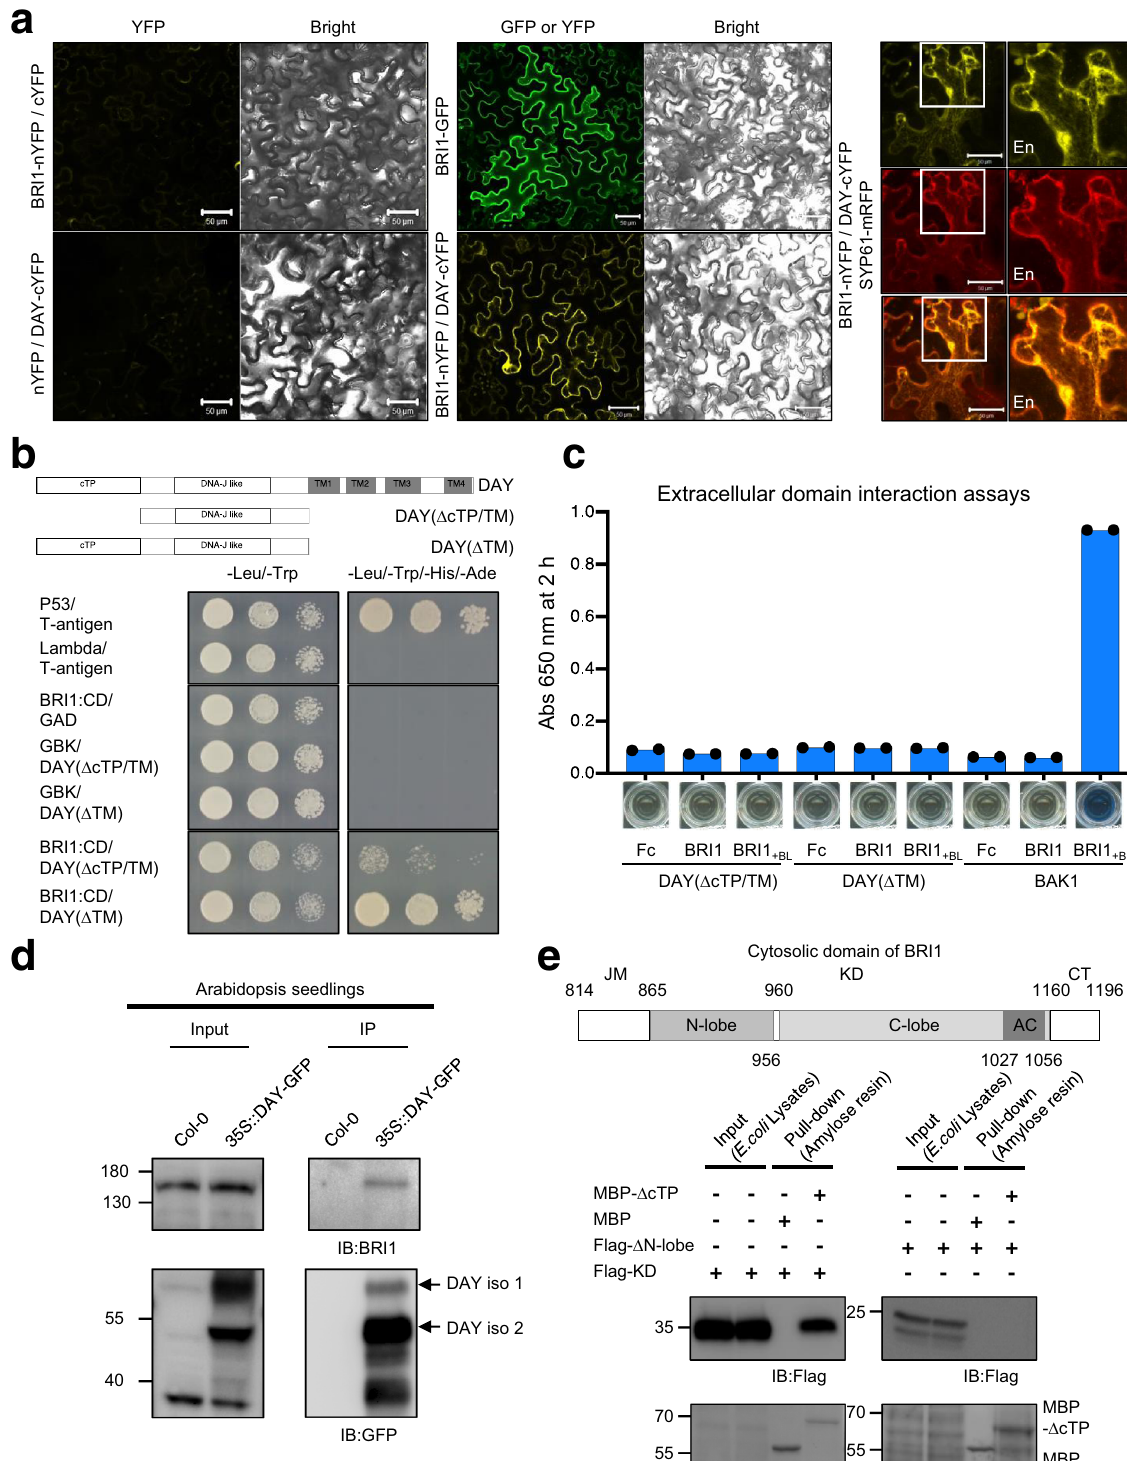
(Fig. 5a). The puncta-localized BiFC interaction signal co- presence of the cTP (Fig. 5b). Extracellular domain interaction localized with SYP61-mRFP, pointing to the TGN/EE as sites of assays (EDIA) revealed that DAY does not interact with the DAY-BRI1 interaction (Fig. 5a). To con fi rm this interaction and extracellular domain of BRI1 (Fig. 5c). Finally, immobilized Flag- de fi ne interacting domains, we performed yeast two-hybrid BRI1:CD pulled down both MBP-DAY and MBP- ▵ cTP, but not (Y2H) assays, extracellular domain interaction assays (EDIA) 35 , MBP (Supplementary Fig. 20a), consistent with the Y2H results and pull-down assays. In the Y2H assays, DAY strongly inter- (Fig. 5b). The cTP sequence stimulated the binding between DAY acted with the cytosolic domain of BRI1 (BRI1:CD) in the and BRI1 CD in both the Y2H and the pull-down experiments. NATURE COMMUNICATIONS| (2021) 12:4194